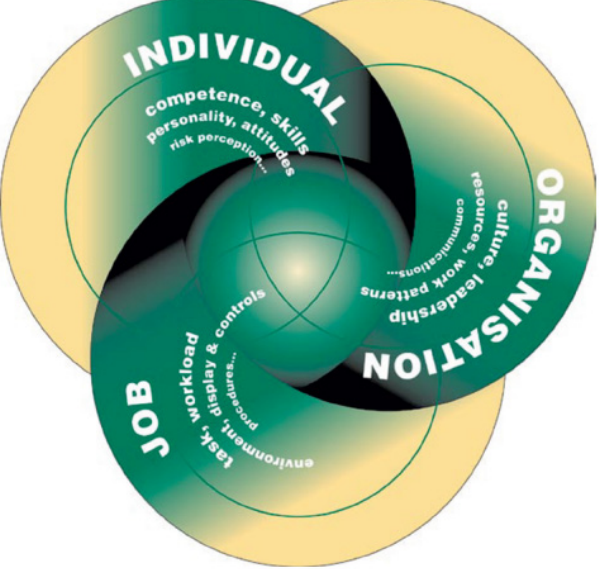
Figure 14. Some elements of human factors in occupational health and safety. (This image is re- used/reproduced with permission of the Health and Safety Executive under the terms of the Open Government License, Courtesy: HSE, UK. Source: